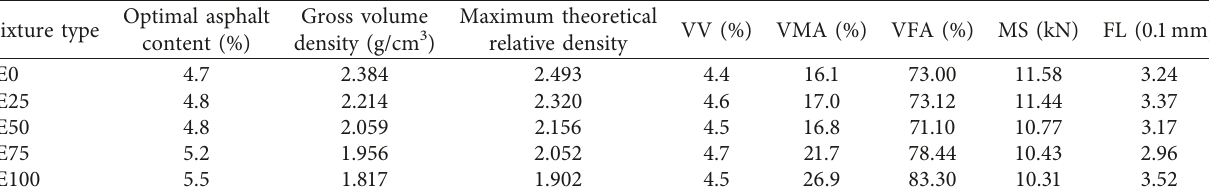
Table 4: Results of the mixture with different CE proportions.